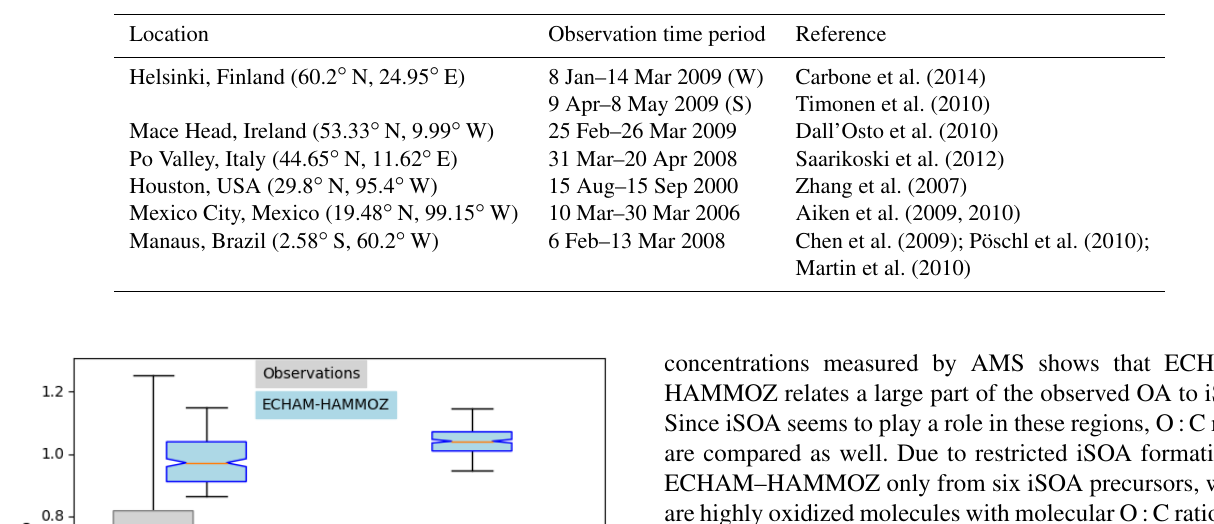
Table 7. Overview of ambient measurement locations, time periods and references. For Helsinki there are two time series, one during winter (W) and the second during spring (S).